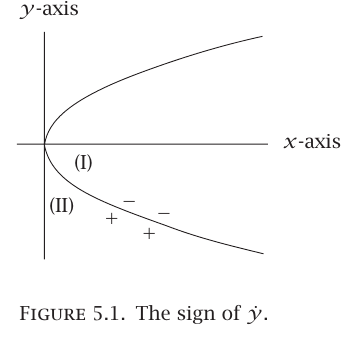
Figure 5.1 . The sign of ˙ y .